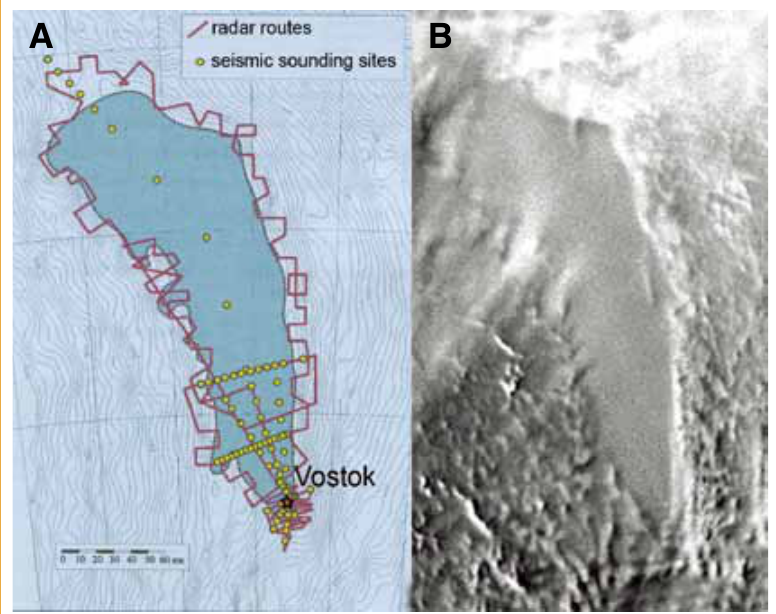
Figure 7. Lake Vostok topography according to [A] geophysical data and [B] Antarctic surface in the region of Vostok from ERS-1 radar altimeter data.